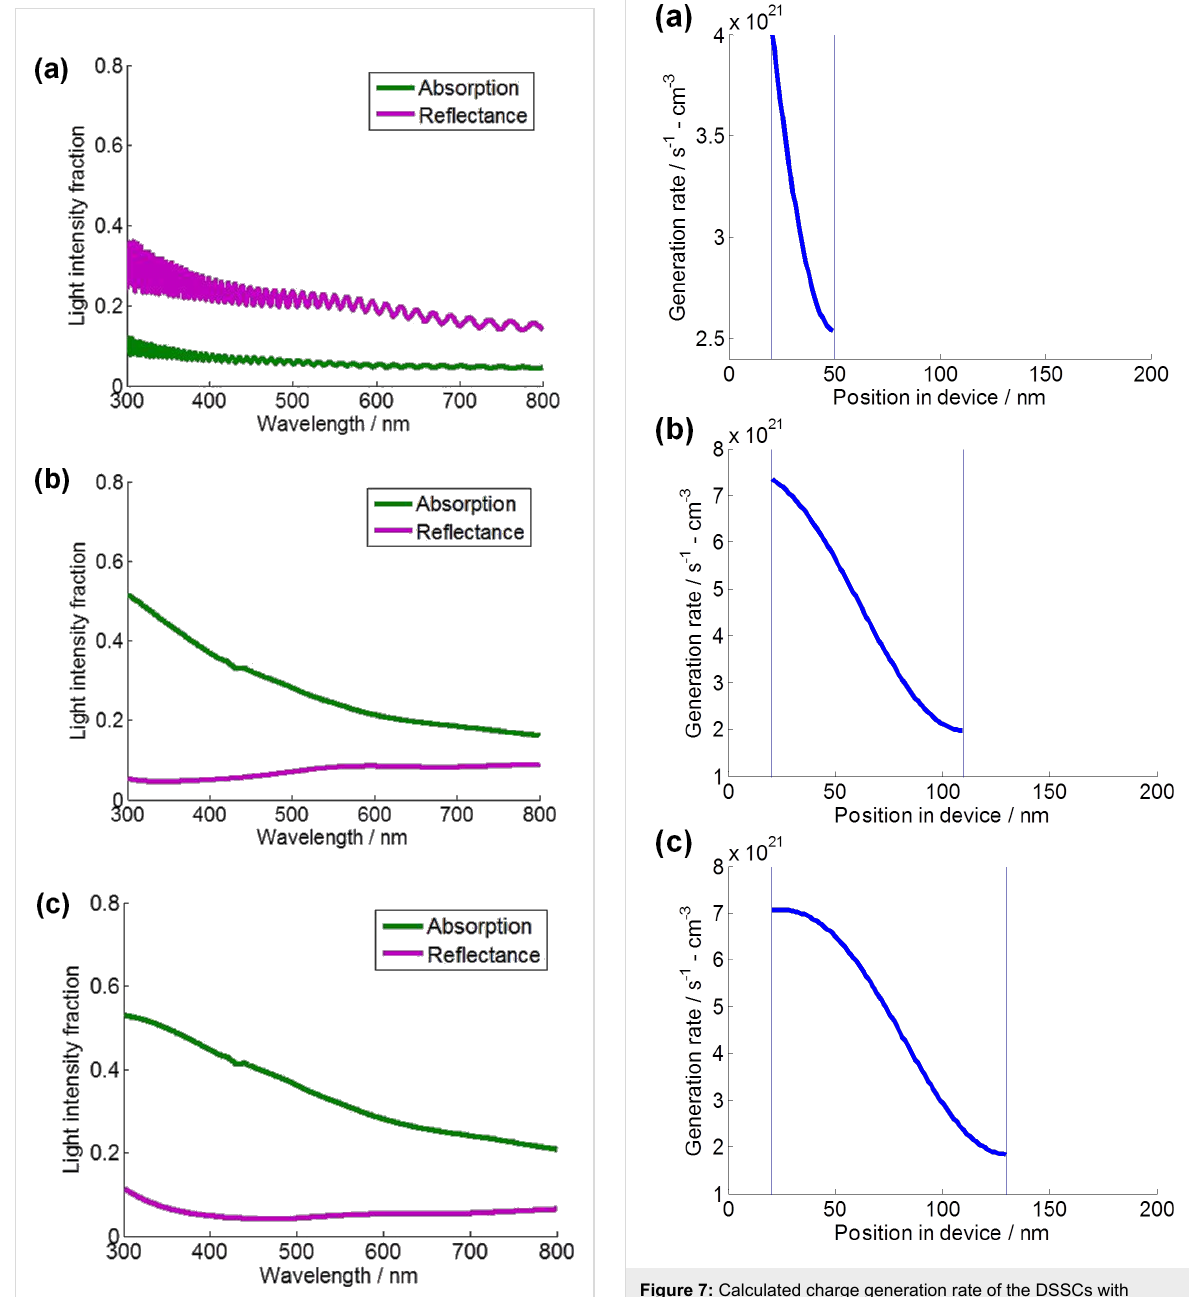
Figure 7: Calculated charge generation rate of the DSSCs with different TNT lengths using GTMM under 1 sun condition (100 mW·cm − 2 ). Charge generation rate for DSSCs with (a) 30 nm thick electric field-valid layer of a 3.3 μ m long TNT array, (b) 90 nm thick electric field-valid layer of a 11.5 μ m long TNT array, and (c) 110 nm thick electric field-valid layer of a 20.6 μ m long TNT